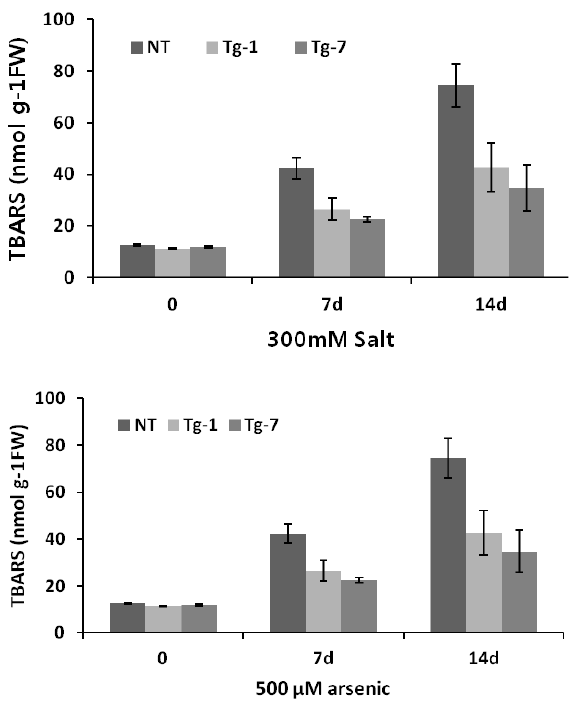
Figure 6. Effects of salt and arsenic stresses on TBARS accumulation in leaves of control (NT) and transgenic (Tg-1, Tg-7) plants. Data represent the means and standard deviation (SD) of 3 independent measurements.